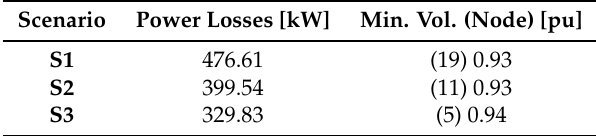
Table 6. Behaviour of the power losses in the 23-nodes test feeder for each simulation